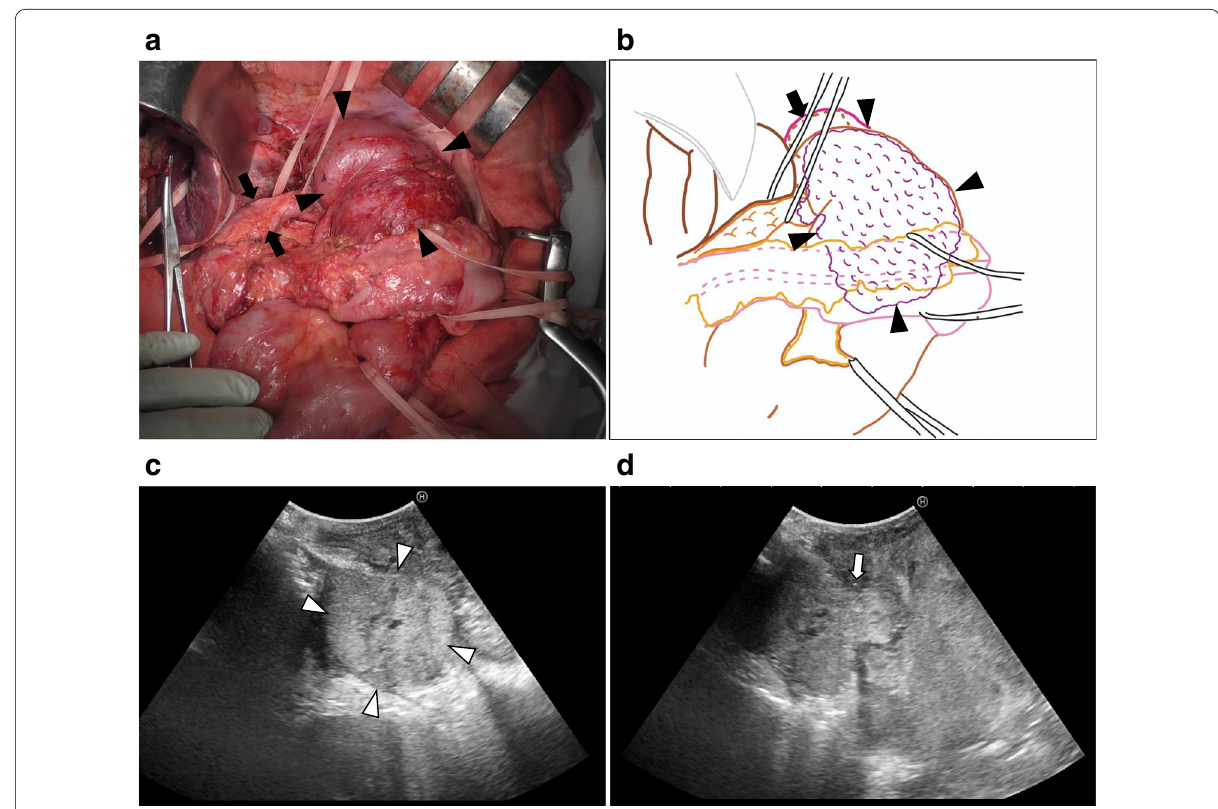
Fig.2 Intraoperative findings. a The jejunal limb (arrowhead) was enlarged and occupied by the tumor thrombus (arrow). b A schema of pancreatic metastasis. Pancreatic metastasis extended into the jejunal limb and caused a tumor thrombus filling the jejunal limb (arrowhead). The tumor thrombus was not reached at the abdominal esophagus (arrow). c , d Intraoperative ultrasound sonography. c Massive tumor in the pancreatic tail (arrowhead). d The tumor extended into the lumen of the jejunal limb